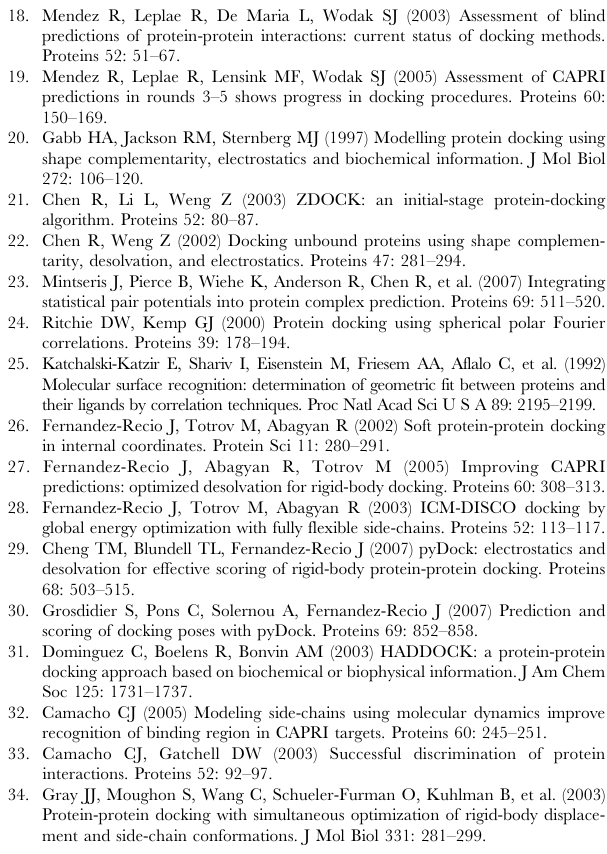
Table S3 Results of the large scale docking experiment. The table reports all the interactions for which it was possible to calculate a docking prediction. The first two columns are the ORF names of the proteins involved in the interaction. The third and fourth columns are the corresponding structures. For experimental structures these fields correspond to the PDB ID and chain, for models the name of the model corresponds to the Swiss-prot id plus an index. Models can be downloaded from http://gatealoy. pcb.ub.es/docking_paper/. The name of the PDB file in the downloadable tarball corresponds to the model name. The fifth and sixth columns indicate if the structures are complete experimental structures, complete models or partial models. The seventh column is the average score of the top 3 solutions, while the eighth column contains YES if the score is above the confidence threshold and NO otherwise. The ninth column is the name of the tarball containing the results (results can be downloaded from http://gatealoy.pcb.ub.es/docking_paper/). The last two columns indicate which one of the two structures is the receptor (chain A in the complex) and which one is the ligand (chain B in the complex). Table S4 Docking cases in the high-confidence interactome for which there is an experimental structure for the interaction. The format is the same of the one for Table S3. An additional column list the best classification that can be reached by the docking predictions when compared to the experimental structures of the interaction.